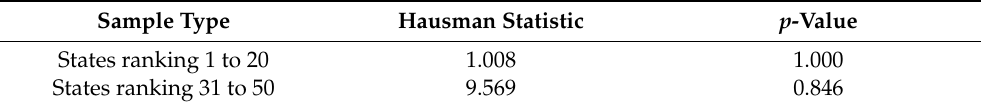
Table 7. Hausman test results of two sub-samples of Model (1).